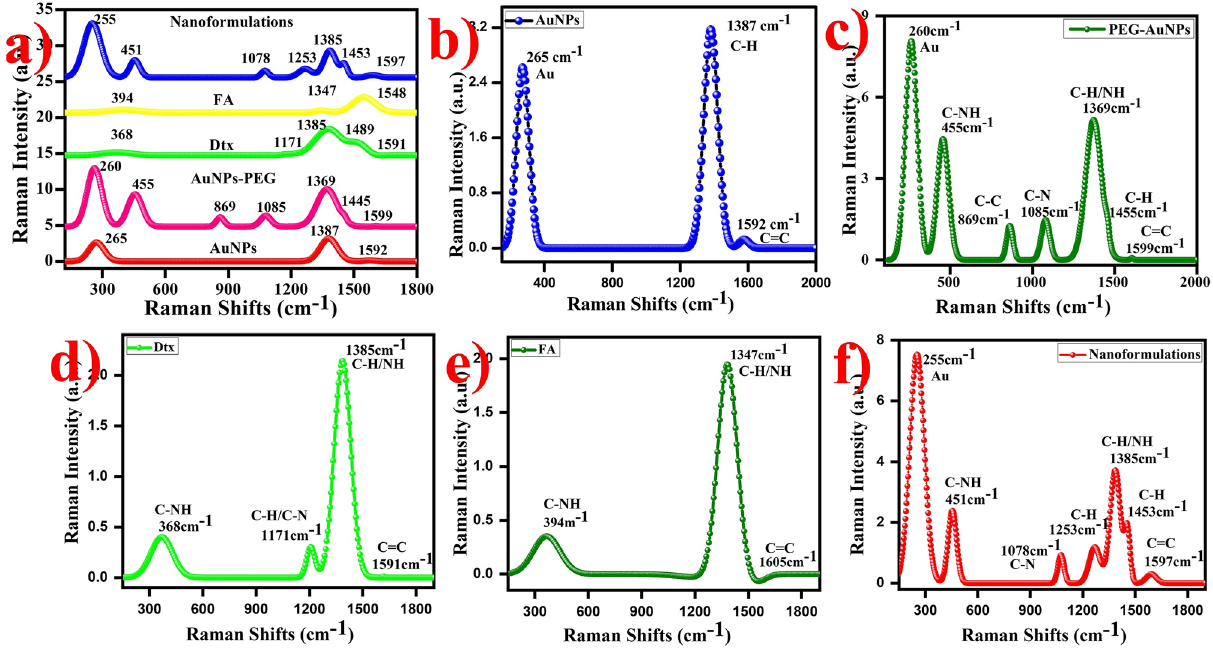
Figure 8. Raman spectra of the gold nanoformulations ( a ) Combined spectra of AuNPs nanoformulations, ( b ) AuNPs ( c ) AuNPs-PEG, ( d ) Dtx, ( e ) FA and ( f )